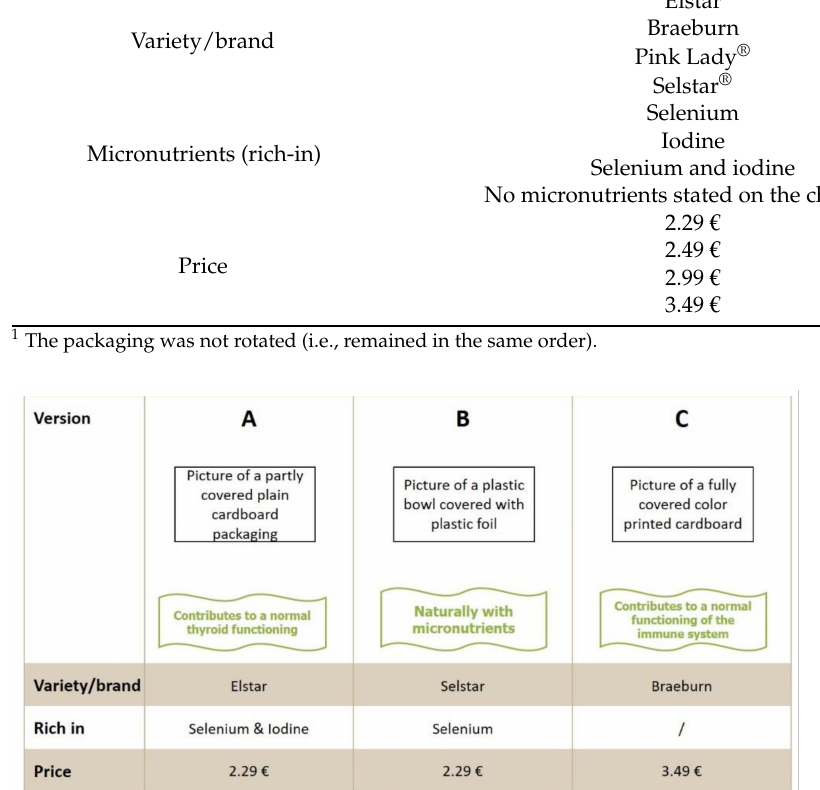
Figure 1. Example of one choice set card with three choices ( A – C ) out of a total of twenty set cards with different choice